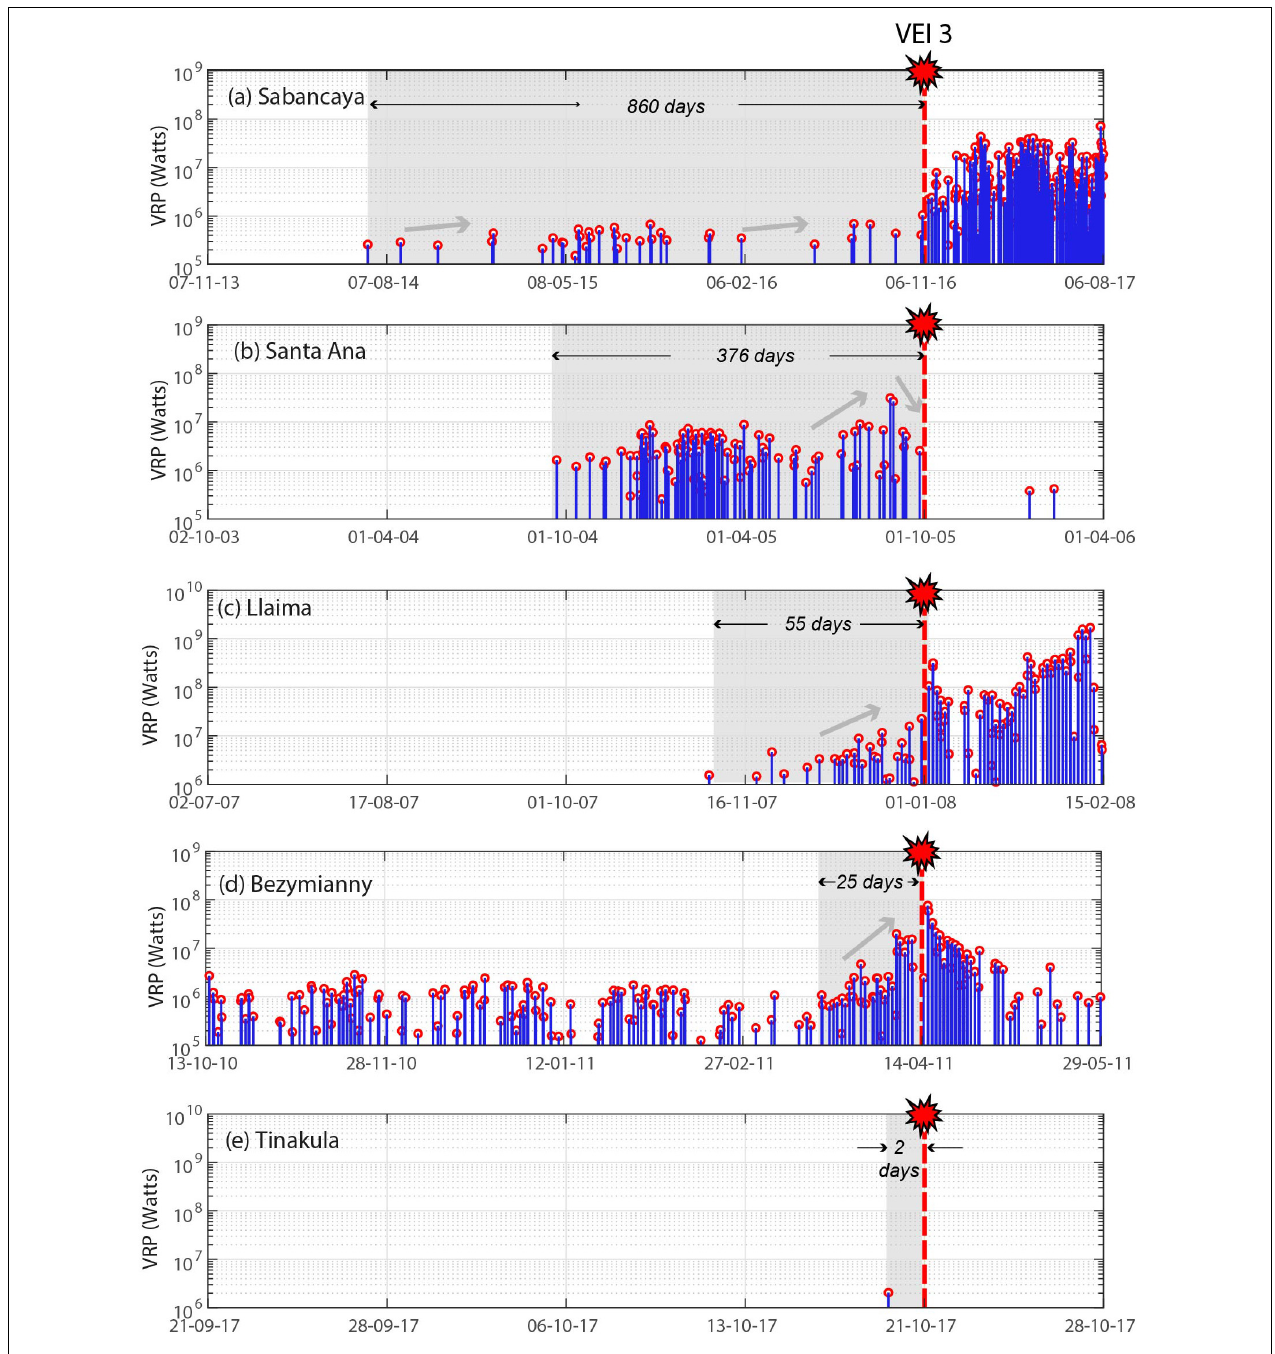
FIGURE 7 | Five cases of thermal unrest detected by MIROVA: (a) Sabancaya, (b) Santa Ana, (c) Llaima, (d) Bezymianny, (e) Tinakula. The red dashed line indicates the occurrence of a large explosion (VEI 3). The gray fields indicate the periods showing precursory thermal activity. The duration of each thermal unrest phase is indicated with arrows. Note how each volcano shows different behavior of thermal unrest in terms of duration, pre-eruptive level and trend, as well as post-eruptive pattern. See the text for more